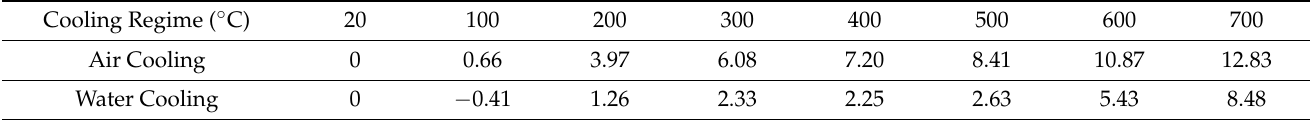
Table 2. Mass loss of SCC specimens after heating and cooling